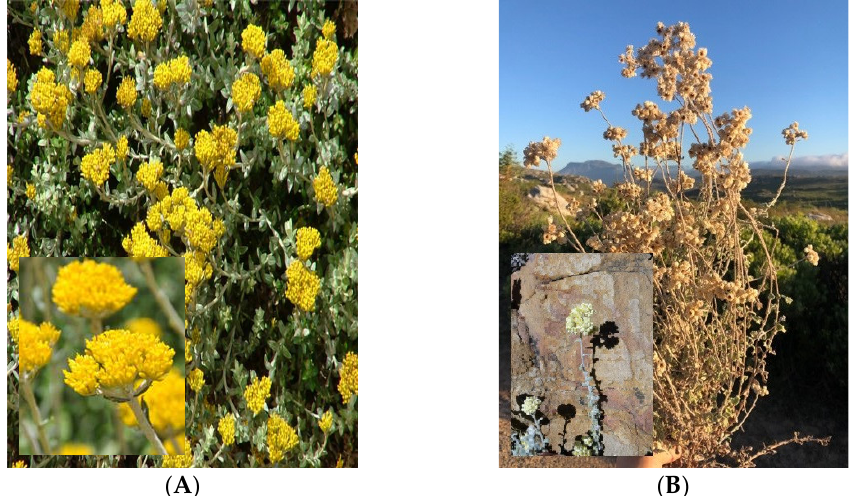
Figure 1. Photographs of H. cymosum ( A ) and H. pandurifolium ( B ) (SANBI; http://pza.sanbi.org, accessed on 7 April 2022).